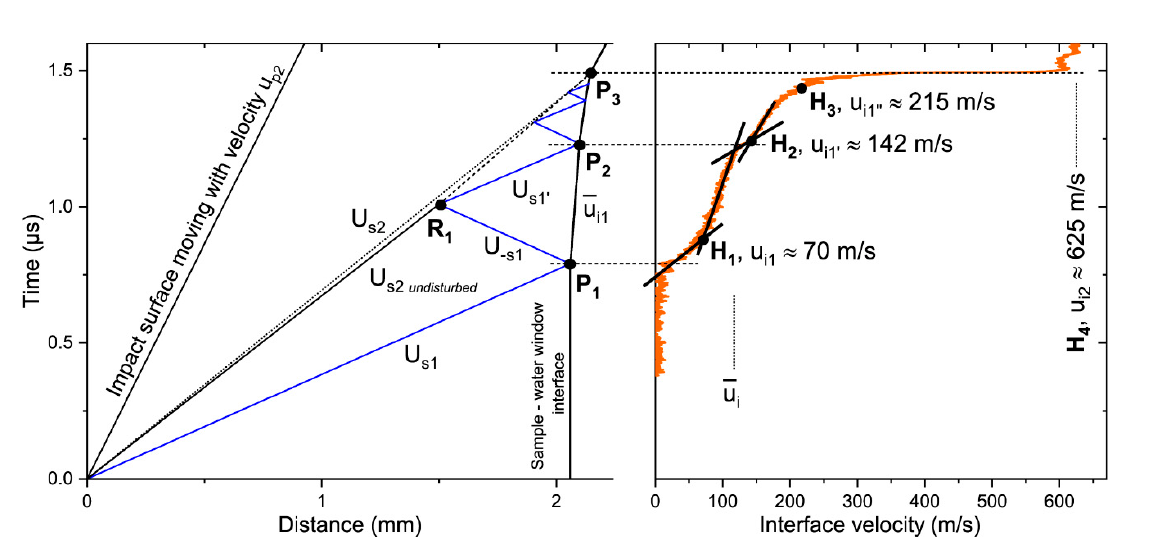
Figure 9. Pressure–particle velocity diagram for Experiment 5. The points H 1 –H 4 are the shocked states in the water window after the precursor (H 1 ), its reflections (H 2 , H 3 ), and compaction wave (H 4 ) arrivals. These were obtained using the water Hugoniot and the velocity profile (see Figure 10). The LiF Hugoniot is shown for comparison. The reflected solid Ni Hugoniot drawn from the point ( u p 2 , p 2 ) nearly crossed the point H 4 , which demonstrates that probably all pores of the sample were collapsed by the compaction wave.